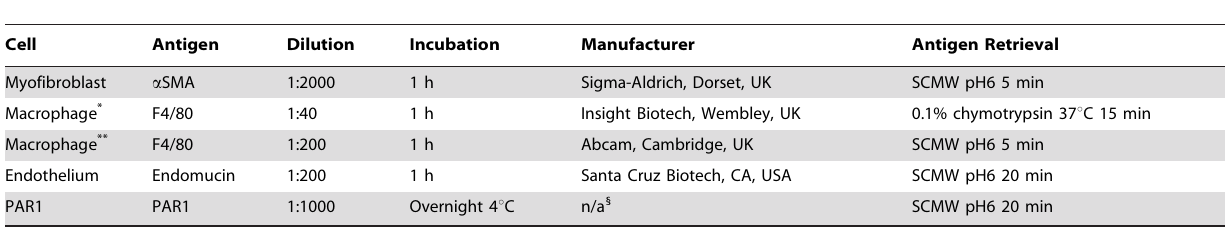
Table 1. Details of primary antibodies used for immunohistochemistry.